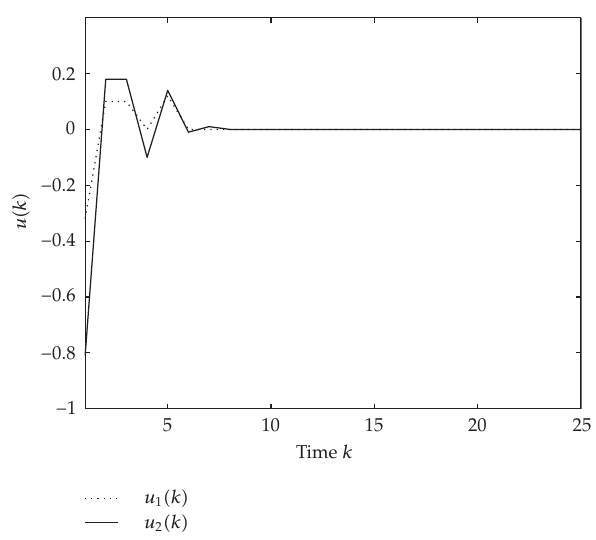
Figure 3: Control input of the switched discrete-time systems.